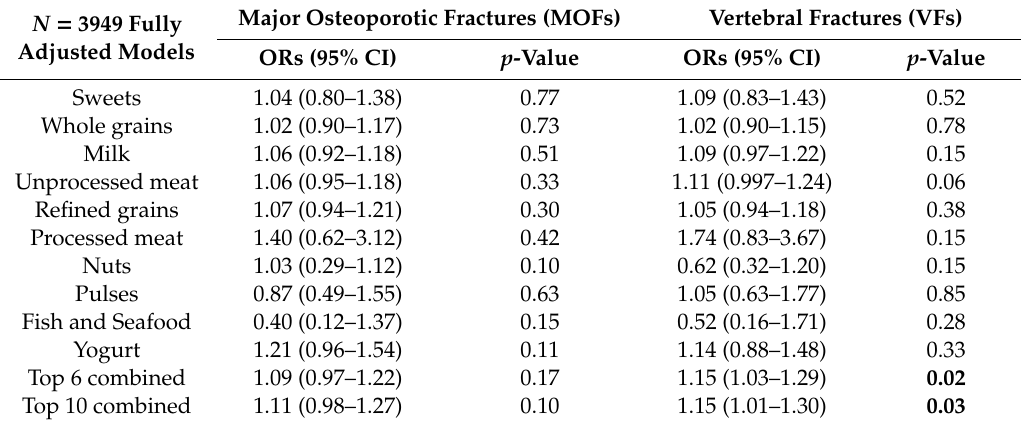
Table 4. Odds ratio of MOFs and VFs for energy-adjusted CML from the top food categories contributing the total CML intake.